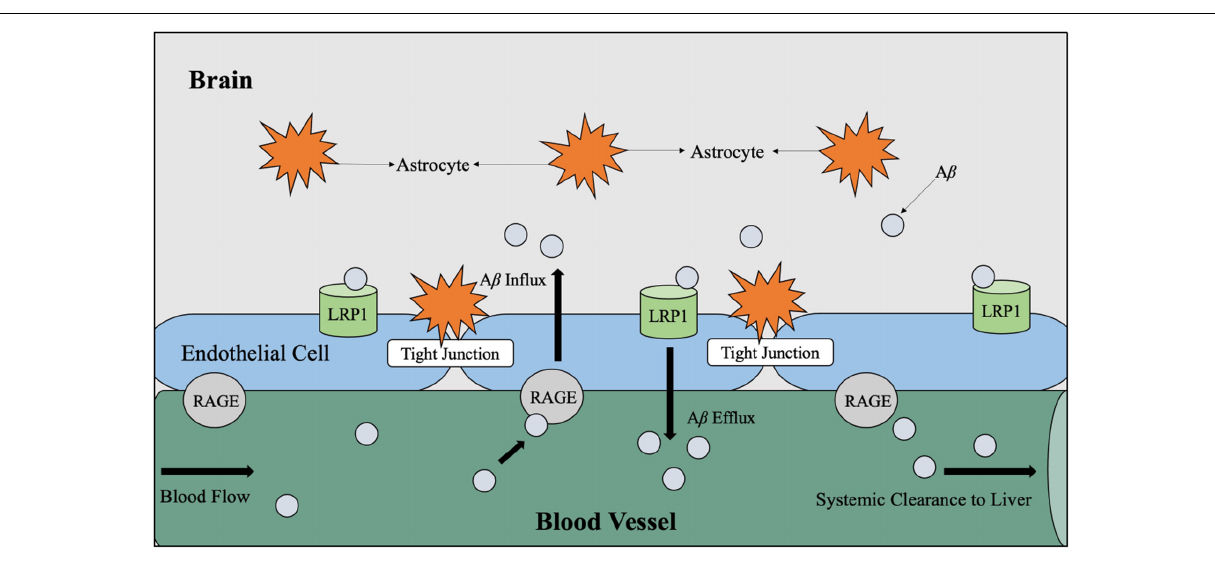
FIGURE 5 | LRP1 and RAGE-mediated A β transport across the BBB. A β travels through the blood vessels to cross the BBB for systemic clearance by the liver. In the periphery, A β binds to RAGE, which is the receptor for AGE believed to be produced as a result of hyperglycemia. When A β binds to RAGE, A β influxes into the brain via endothelial cells. Counteracting A β influx into the brain, A β efflux into the periphery is mediated by LRP1. Abbreviations: LRP1, lipoprotein receptor-related protein; RAGE, receptor for advanced glycation end products; A β , amyloid beta; BBB, blood-brain barrier; AGE, advanced glycation end